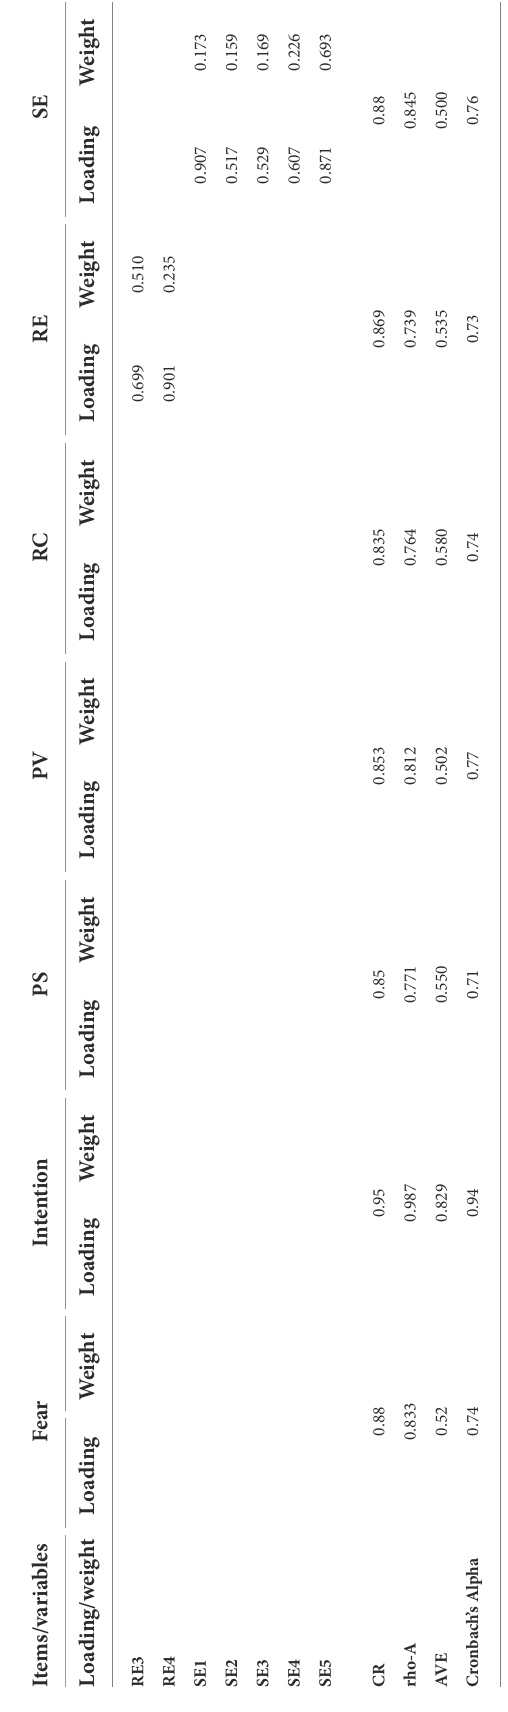
TABLE 4 Outer VIF values for the measuring